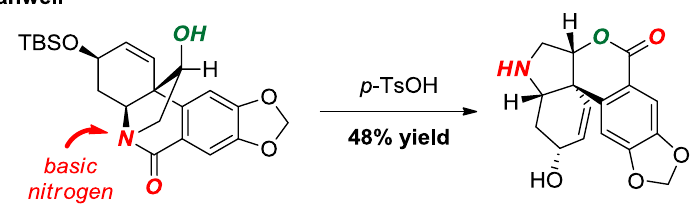
Figure 20. Lactam-to-Lactone Rearrangement of a Bridged Lactam in Haemanthidine Alkaloids.